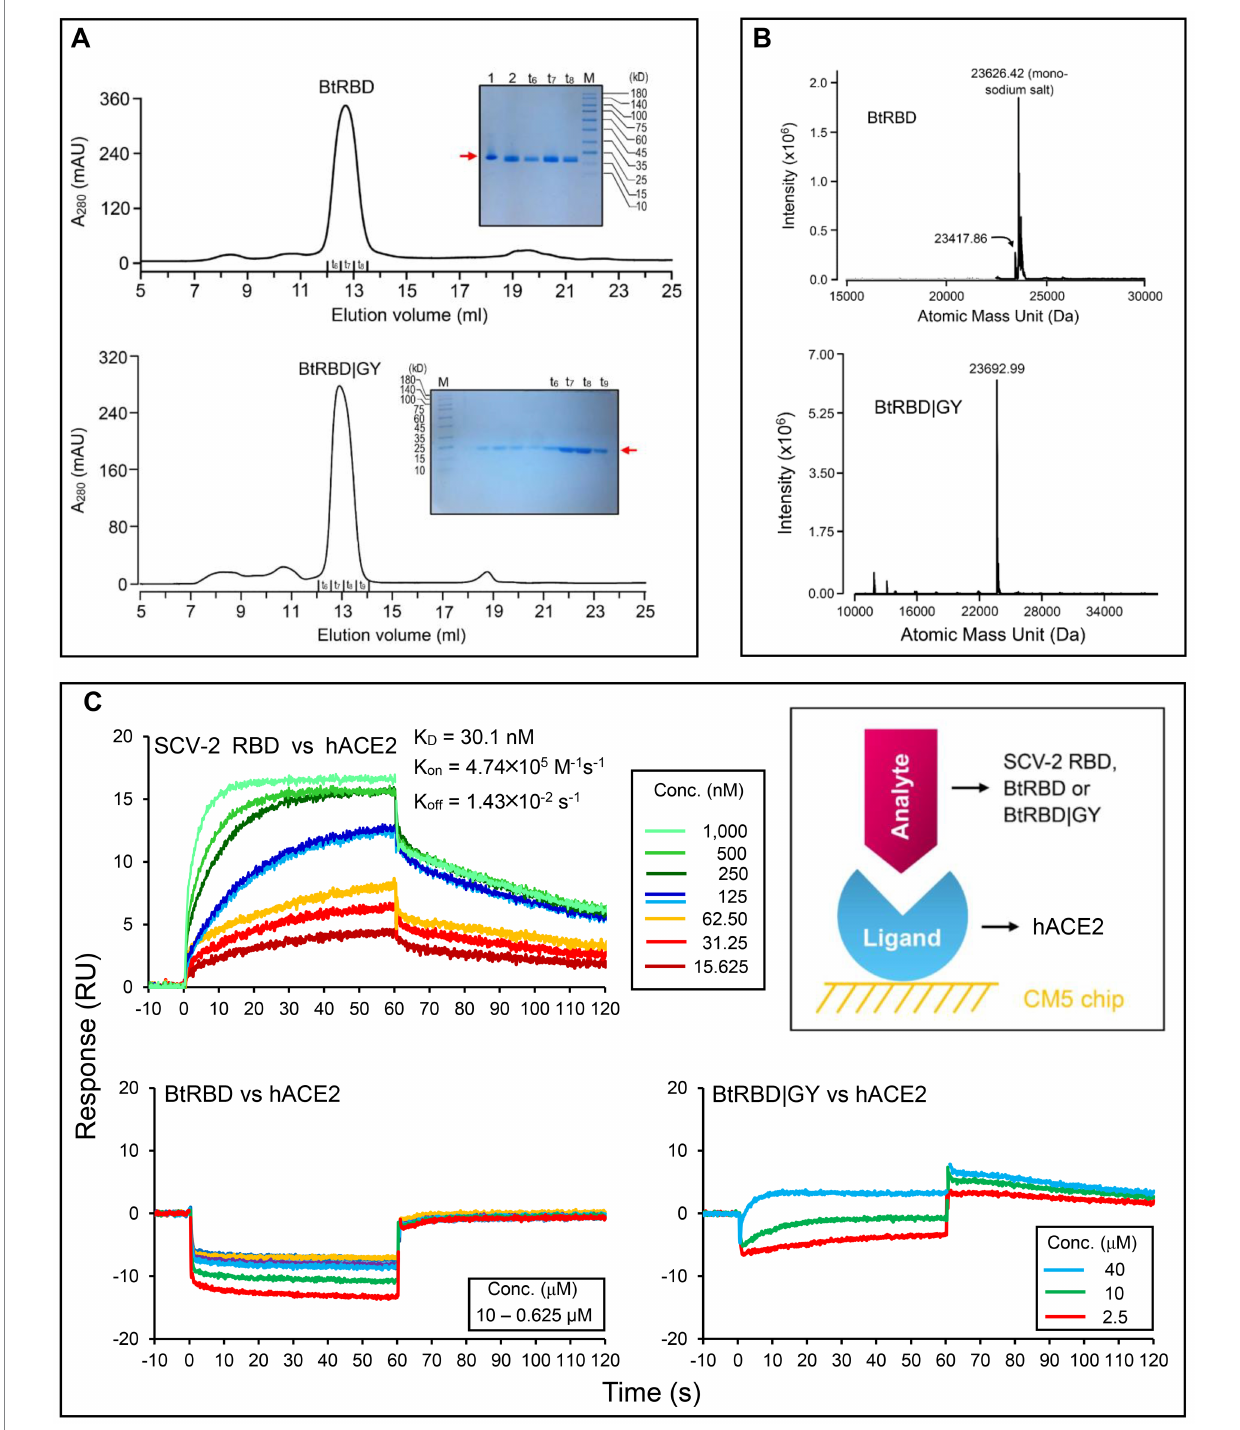
FIGURE 7 Purification, identification and functional characterization of recombinant RBDs. (A) Purification of refolded BtRBD and BtRBD|GY by SEC. Inset: SDS- PAGE analysis of the purified products, marked by a red arrow. “t 6 to t 9 ” denote collection tubes in SEC and “M” denotes protein molecular weight standard. (B) HPLC-Q-TOF-MS determining the molecular mass of BtRBD and BtRBD|GY. (C) Sensorgrams of SARS-CoV-2 RBD binding to the ACE2- immobilized chip surface (left top). The 125 nM analyte concentration was analyzed in duplicate. The concentrations used were 1,000–15.625 nM with two-fold serial dilutions. Sensorgrams of BtRBD to the chip surface (left bottom). The concentrations used were 10,000–625 nM with two-fold serial dilutions. Sensorgrams of BtRBD|GY to the chip surface (right bottom). The concentrations used were 40,000, 10,000, and 2,500 nM. Inset, schematic diagram of SPR experiment, in which the ligand hACE2 was covalently immobilized onto CM5 via its amine groups and the analytes (RBDs) flowed over the